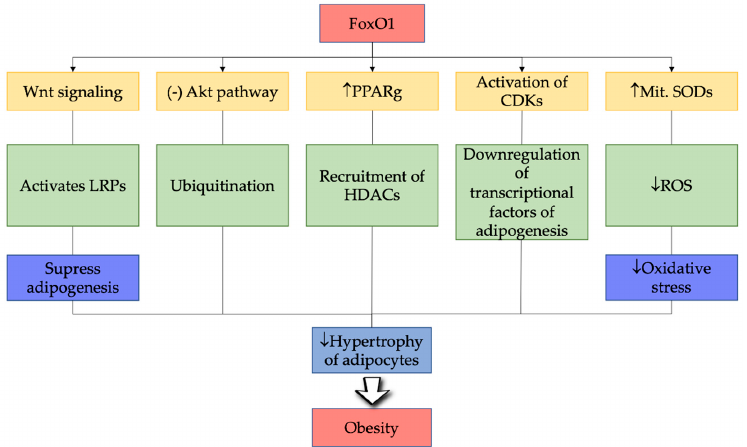
Figure 3. Mechanistic approaches of FOXO1 in obesity. Legend: FoxO1—forkhead box protein O1; PPARg—peroxisome proliferator-activated receptor gamma; CDKs—cyclin-dependent kinases; ROS—reactive oxygen species; SODs—superoxide dismutases; HDACs—histone deacetylases; LRPs—laterized readiness potential; ↑ — increase; ↓ — decrease.